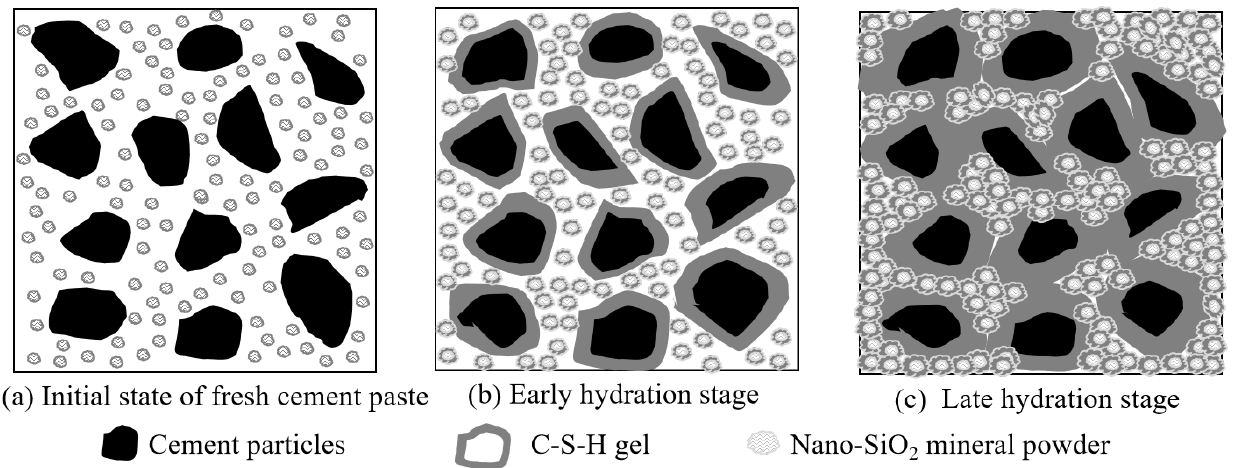
Figure 6. The reaction mechanism of initial state, early hydration stage and late hydration stage of MP-CBM.